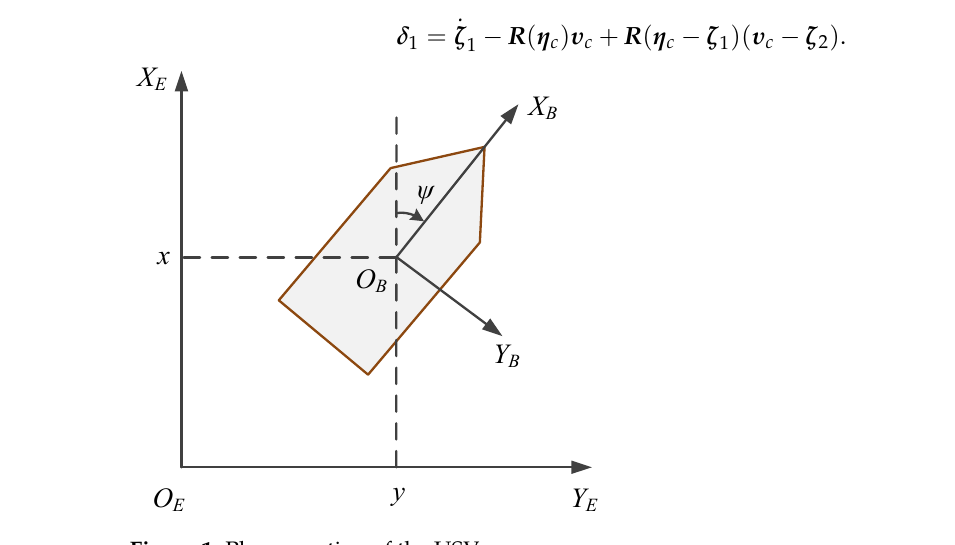
Figure 1. Planar motion of the USV.